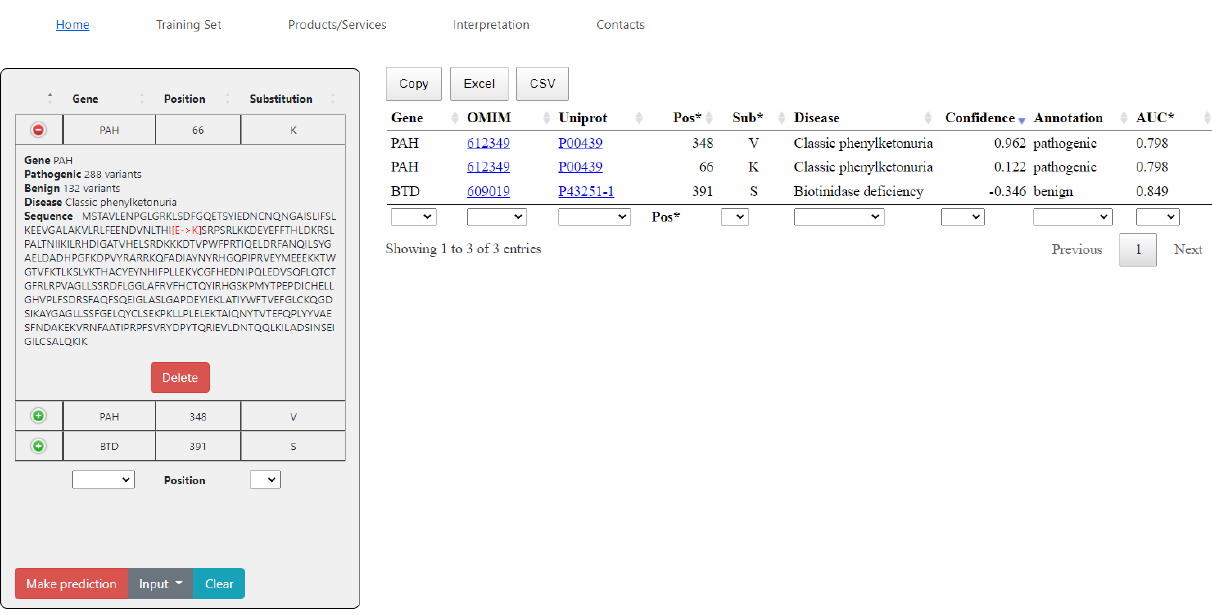
Figure 2. SAV-Pred web page with prediction results for the input example. On the left part of the screen, the input list form contains gene name, sample counts in the training set, associated disease and protein sequence with marked red substitution. The result table with confidence score as well as its interpretation and ROC-AUC metrics are located on the right side. The examples were published in the ClinVar database after May 2022 and were not included in the training sets of the appropriate SSPR models. All three predictions are consistent with the current clinical classification in the ClinVar database.